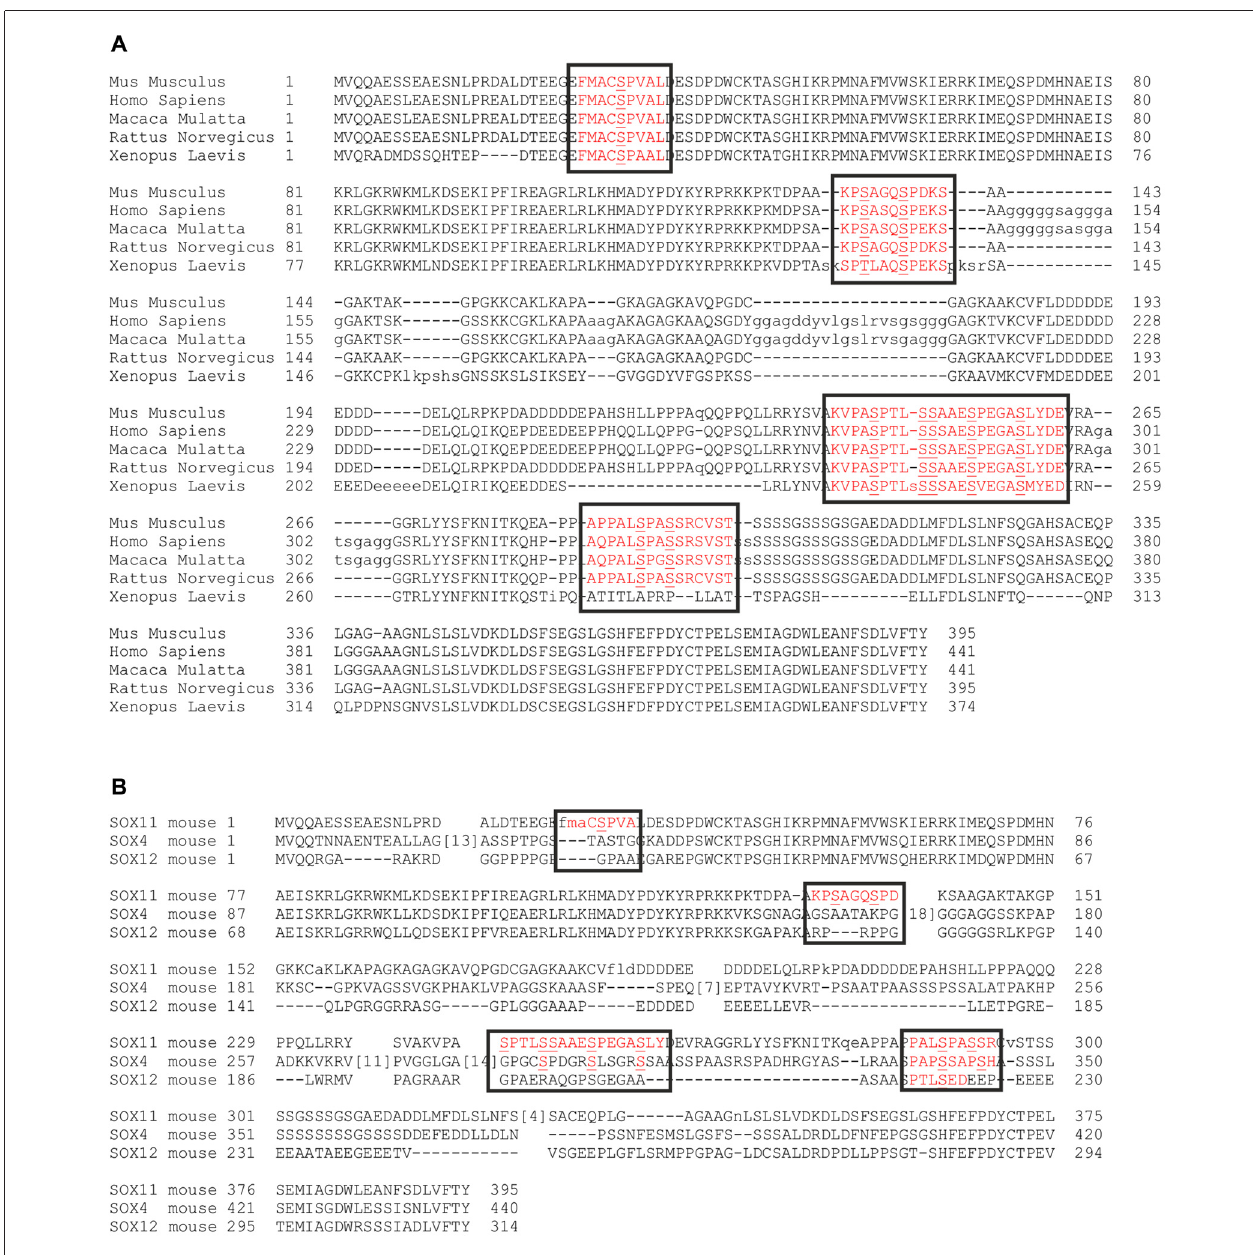
FIGURE 4 | Conservation of the phosphorylatable serines. Alignment of SOX11 amino acid sequence from different species shows the conservation of the phosphorylatable serines (A) . Alignment of murine amino acid sequences of SOX11 (row1), SOX4 (row2) and SOX12 (row3) shows the conservation of the phosphorylatable serines among the SoxC family (B) . Black boxes indicate the regions of interest. Red letters indicate the occurrence of conservation. Note that the phosphorylatable serines surrounding the HMG-box (S30, S133, S137) are unique to